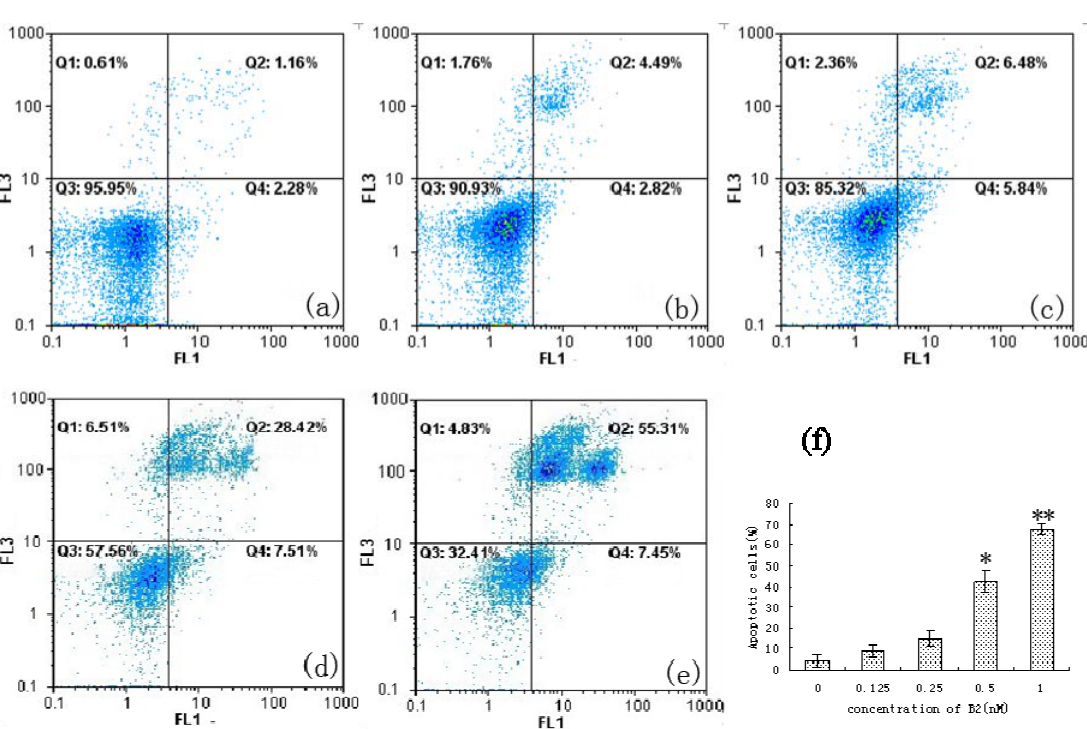
Figure 5. Apoptotic population of SMMC-7721 cells analysis by flow cytometric